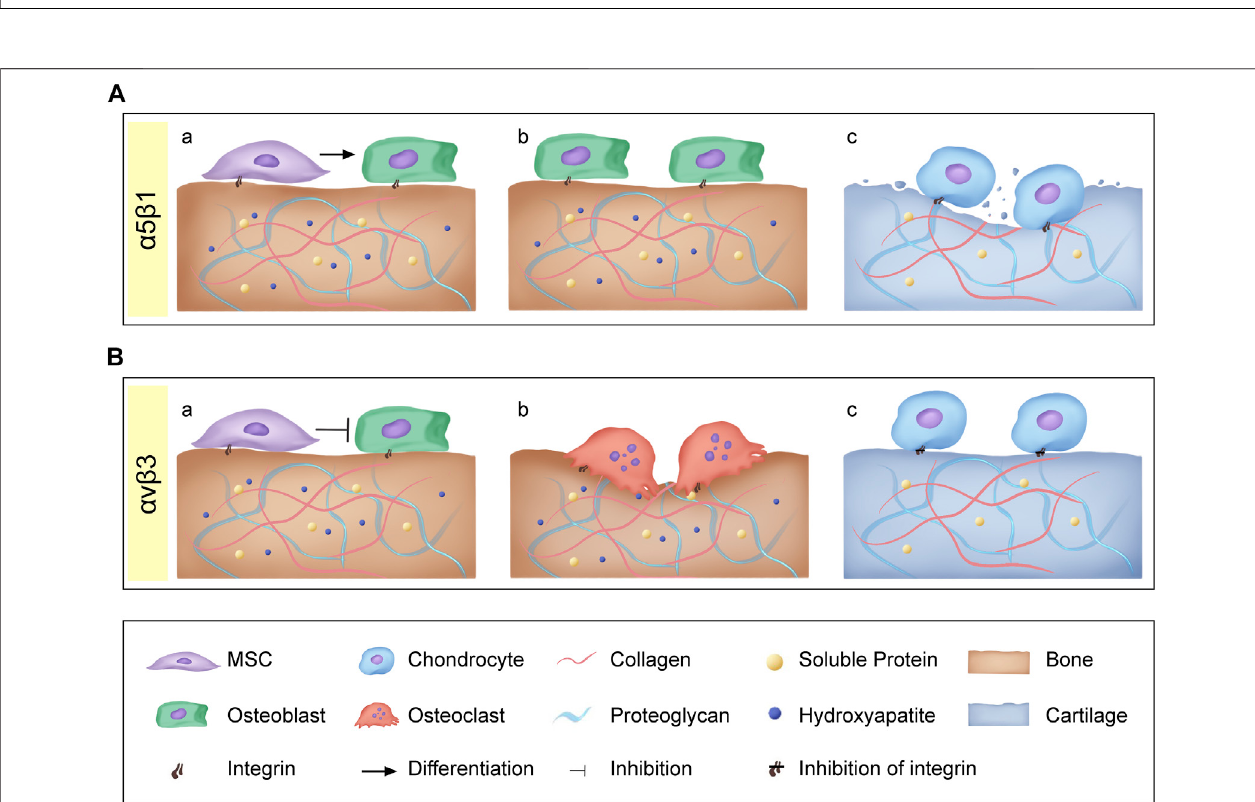
FIGURE 3 | (A) Integrins α 5 β 1: (a) α 5 β 1 promote osteoblastic differentiation of mesenchymal stem cells; (b) α 5 β 1 promote osteoblast proliferation and bone formation;(c) α 5 β 1alsoactivatespro-in fl ammatoryandcatabolicresponsesleadingtocartilagematrixdegradation. (B) Integrins α v β 3:(a) α v β 3InhibitMSCsproliferation and osteogenic differentiation; (b) α v β 3 promote bone resorption; (c) Inhibition of α v β 3 could signi fi cantly inhibit osteoarthritis (OA) in fl ammation and decrease OA progression.